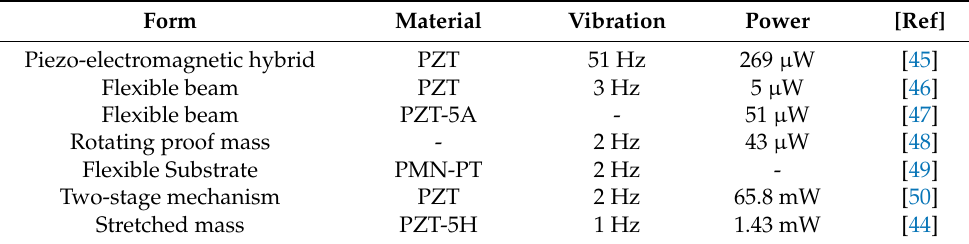
Table 5. Comparison of piezoelectric harvesters.